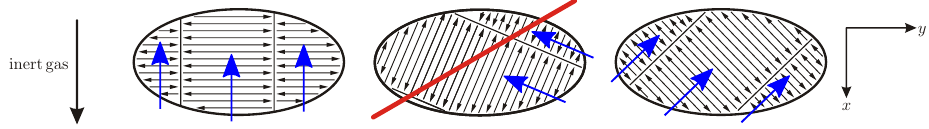
Figure 2. Stripes, scan vectors and scanning sequence of FO1 scanning